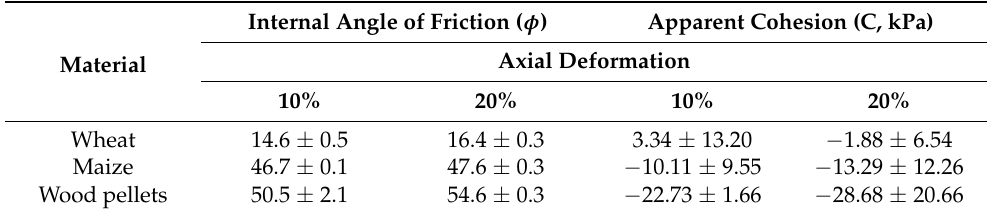
Table 4. Internal angle of friction and apparent cohesion of the tested materials obtained in the triaxial tests at deformations of 10% and 20%.